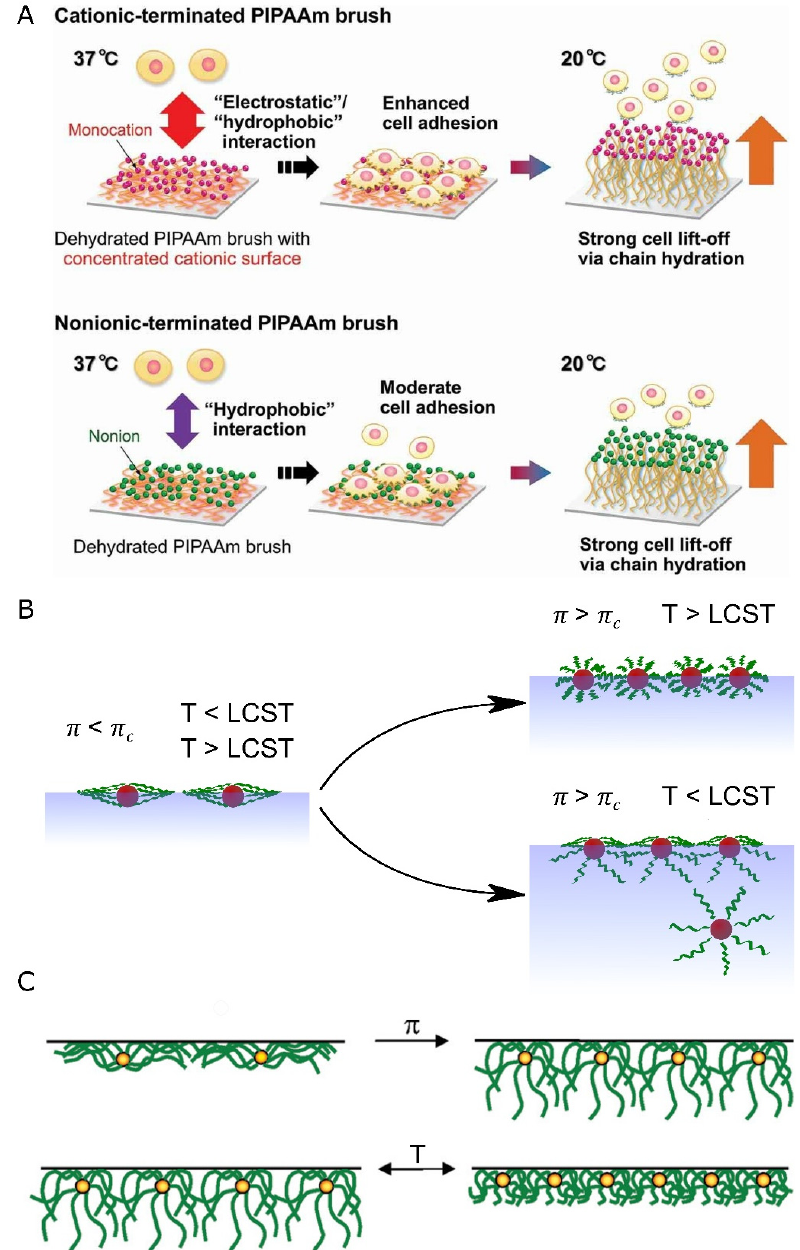
Figure 5. ( A ) Schematic representation of cell adhesion and detachment from native and terminally modified poly(N-isopropyl acrylamide) bushes with a cationic moiety. The modification facilitates the on-demand release of cells from the surface. Figure A was adapted based on Creative Commons license from ref. [250]. Copyright 2021 Taylor & Francis. ( B ) The schematic interfacial behavior of Fe 3 O 4 @MEO 2 MA NPs at the air/water interface. When the surface pressure ( π ) is lower than the critical pressure ( π c ) nanoparticles exist in a “pancake” conformation. If the surface pressure is higher than π c , above LCST NPs coexist in a “pancake” and “brush” conformations; desorption is possible. For π > π c and T > LCST, the NPs film creates a mushroom-like structure on the high ionic strength subphase. The graphics is inspired by ref. [254]. Copyright 2011 Royal Society of Chemistry ( C ) The schematic representation of conformations of AuNPs capped with PNIPAM at the air/water interface. By limiting the surface area and increasing the surface pressure, nanoparticles’ conformation changes from “pancake” to “brush”. Then, the temperature rise decreases the interparticle distance due to the PNIPAM transition. Adapted with permission from ref [252]. Copyright 2009 American Chemical Society. Figure ( A ) used based on Creative Commons